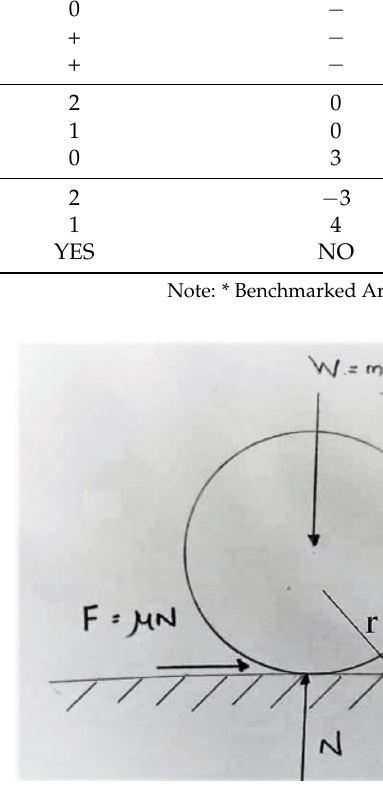
Figure 1. Free-body diagram for the driving